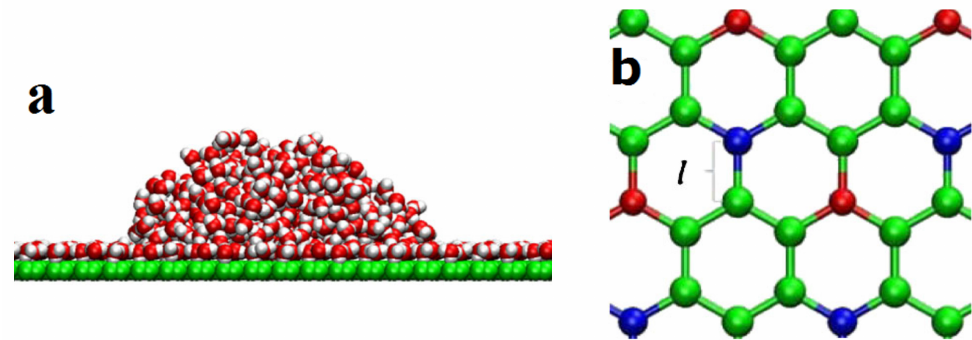
Figure 1. ( a ) A stable water droplet coexists with a thin water monolayer absorbed on a modeled solid surface. ( b ) Structure of the model solid surface with a hexagonal, charged pattern. Red presents the positive-charged atoms, and the blue presents the negative-charged atoms. (Reprinted from Ref. [70], Copyright 2009 American Physical